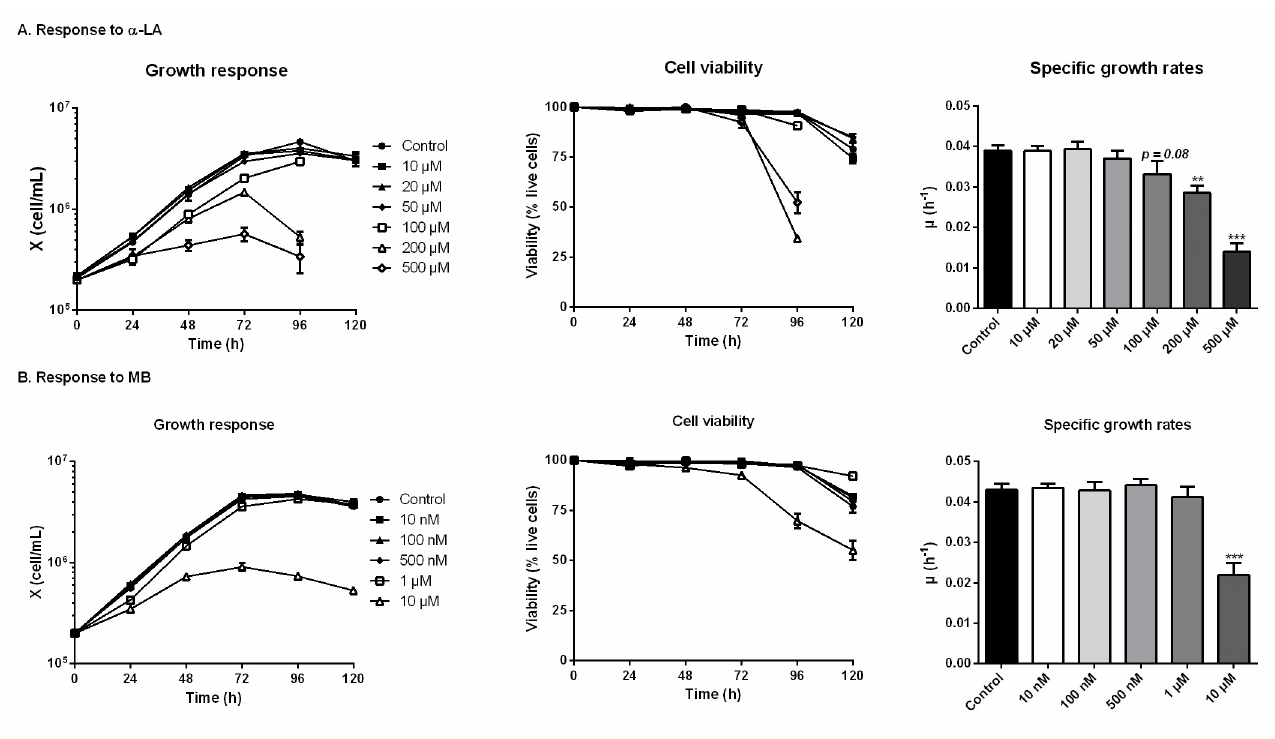
Fig 1. Growth and viability responses of CHO cells to various doses of α -lipoic acid ( Α -LA) and methylene blue (MB). α -LA was tested at 10 μ M, 20 μ M, 50 μ M, 100 μ m, 200 μ M and 500 μ M (A) and MB was tested at 10 nM, 100 nM, 500 nM, 1 μ M and 10 μ M. Growth and viability curves are presented as means ± SEM (n = 3). Specific growth rates were calculated by linear regression during the exponential growth phase, from 0 to 72 h. Statistical significance was determined by one-way ANOVA versus the control culture.